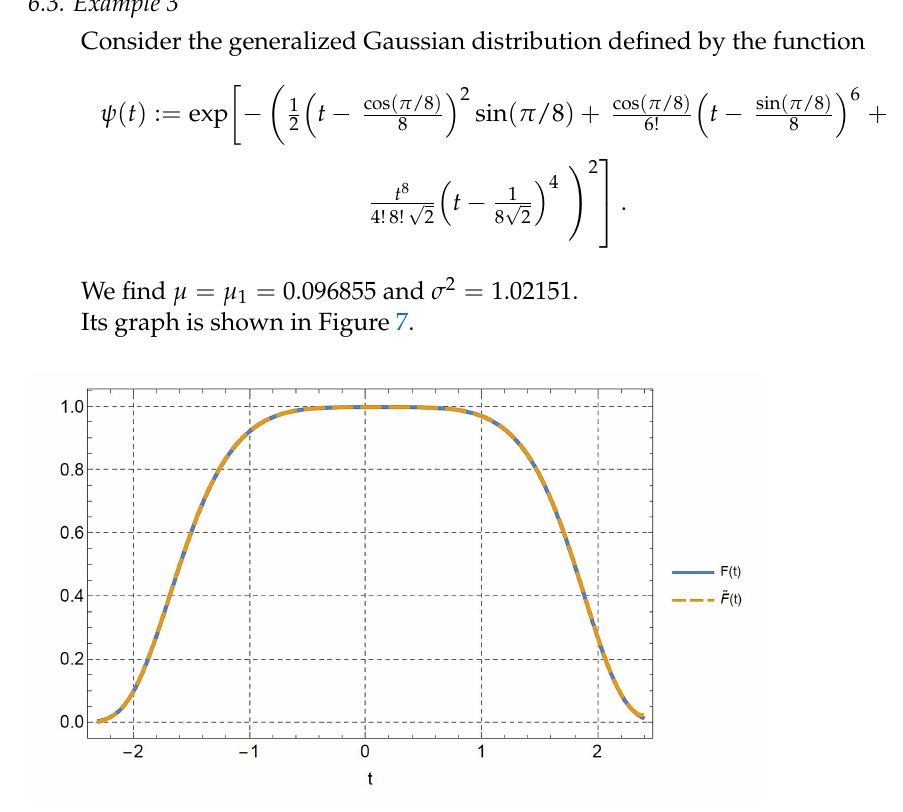
Figure 7. Graph of the function ψ ( t ) in (29).